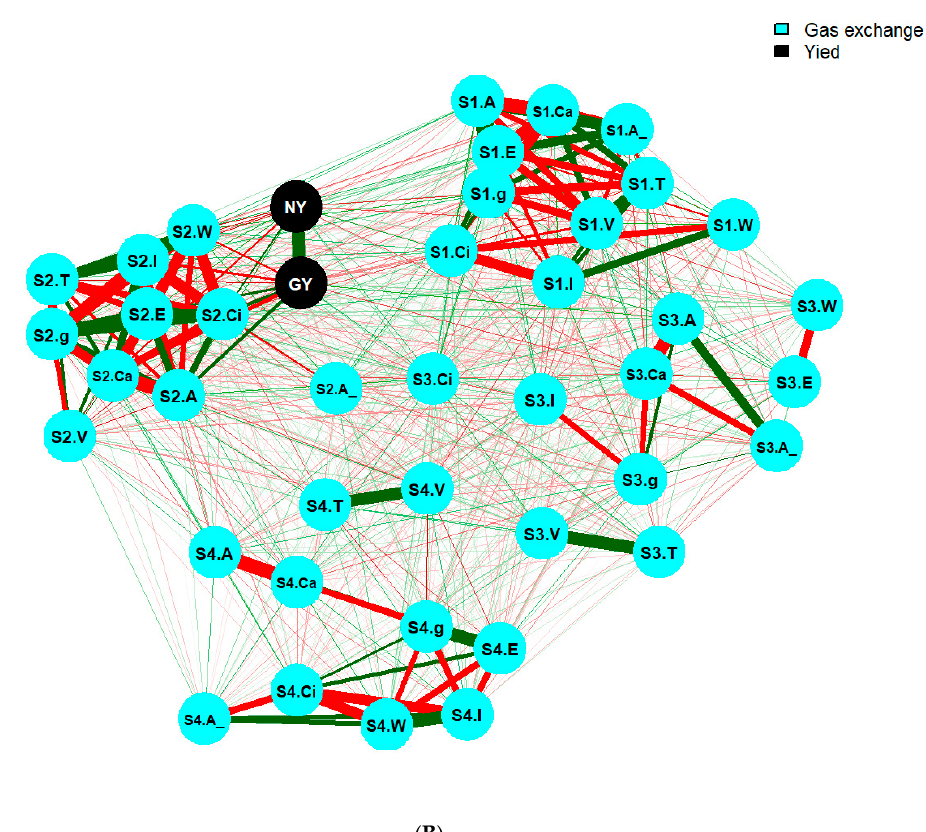
Figure 4. ( A ) Correlation network for coffee physiological variables. Correlations greater than 0.5, positive (green line) or negative (red line), are highlighted (thicker lines indicate higher